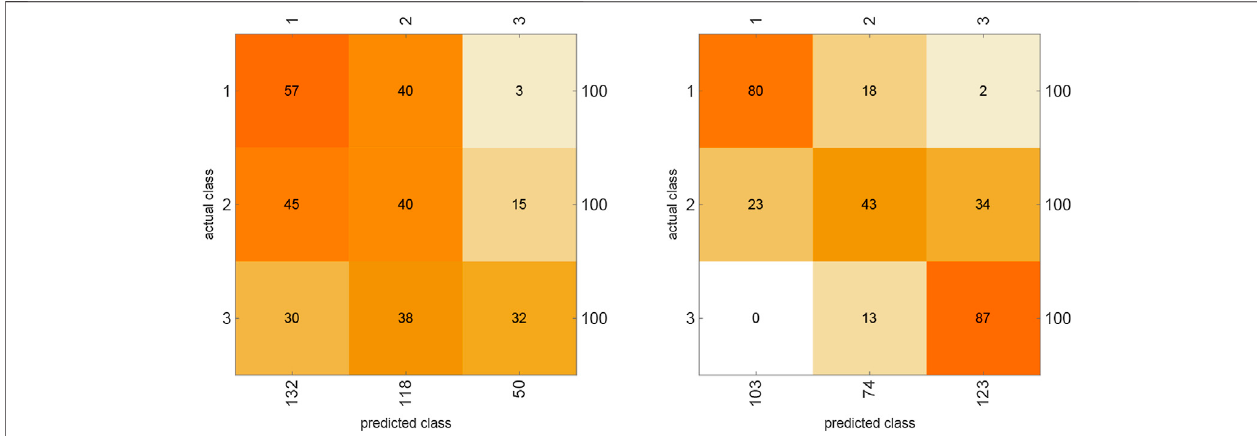
FIGURE6| Theconfusionmatrixfortheneuralnetwork(left)andthealgorithmicinformationclassi fi er(right)whileclassifyingbinaryvectorsrepresentingthedegree of connection (parameter k) of 300 randomly generated Boolean NK networks. From the plots we can see that the algorithmic classi fi er can predict with relatively high accuracy the elements belonging to class k (cid:2) 1 and k (cid:2) 3. The neural network used is considerably more random in its predictions.